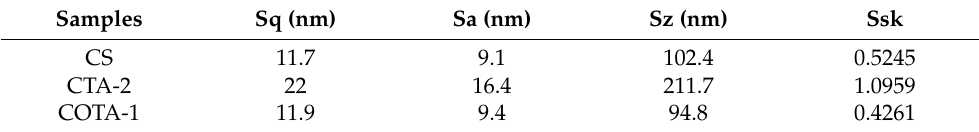
Table 5. The solubility, moisture content, and water uptake of CS ‐ based films. Samples